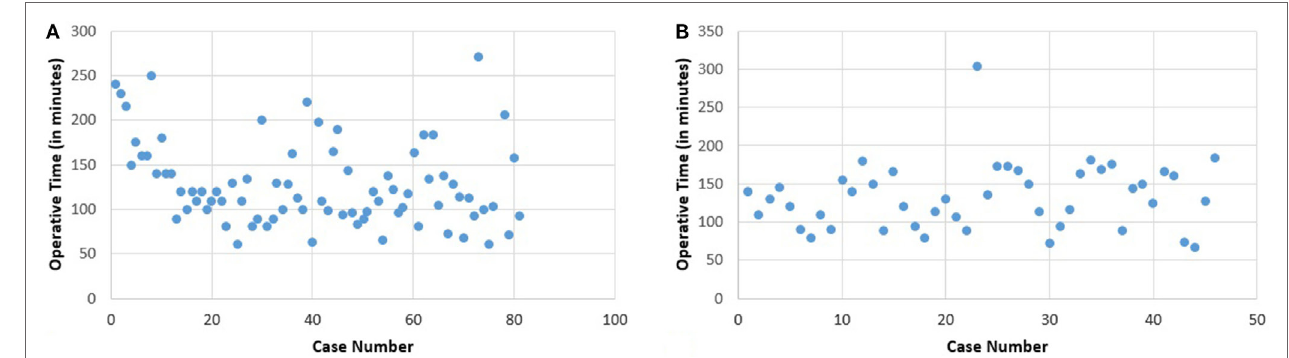
TaBle 4 | comparison between the average of the data for the first 20 cases and the following ones, for “s1” and “s2.” surgeon s1 s2 average of the average of p -Value average of the average of p -Value first 20 cases subsequent cases first 20 cases subsequent cases Age 46.6